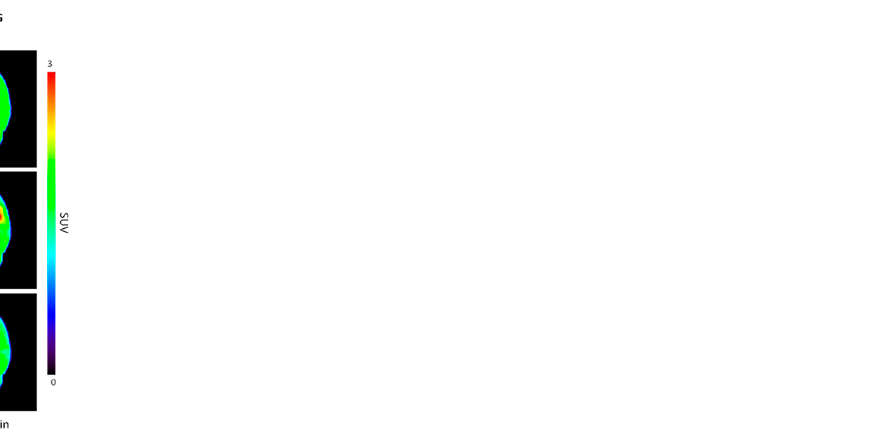
Figure 4. Representative static iterative transverse PET images of [ 18 F]FDG binding in unilateral lipopolysaccharide (LPS)–injected rat striatum. Shown are PET images in male rats at ( A ) 48 h, ( B ) 1 week, and ( C ) 2 weeks post–LPS injection.